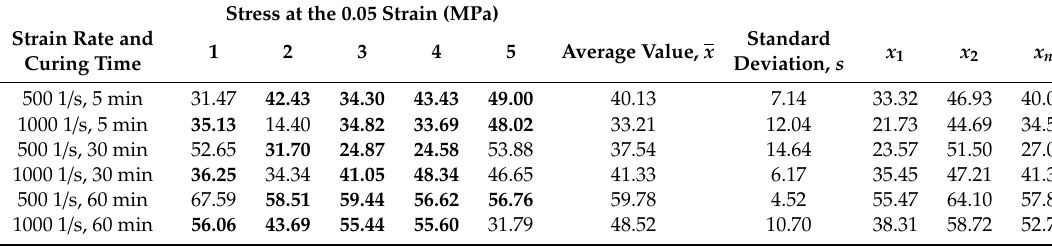
Table 3. Statistical analysis results for the dynamic